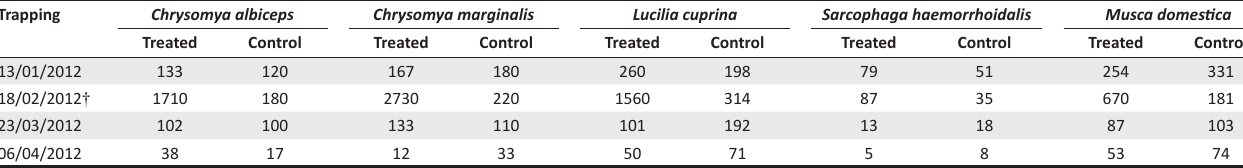
TABLE 1: Number of flies over time on both the treated farm and the control farms. Trapping Chrysomya albiceps Chrysomya marginalis Lucilia cuprina Sarcophaga haemorrhoidalis Musca domestica